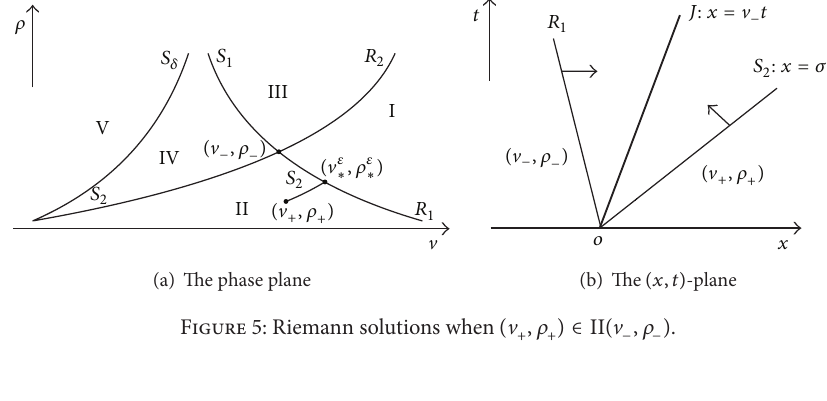
Figure 5: Riemann solutions when ( V + , 𝜌 + ) ∈ II ( V − , 𝜌 − ) .